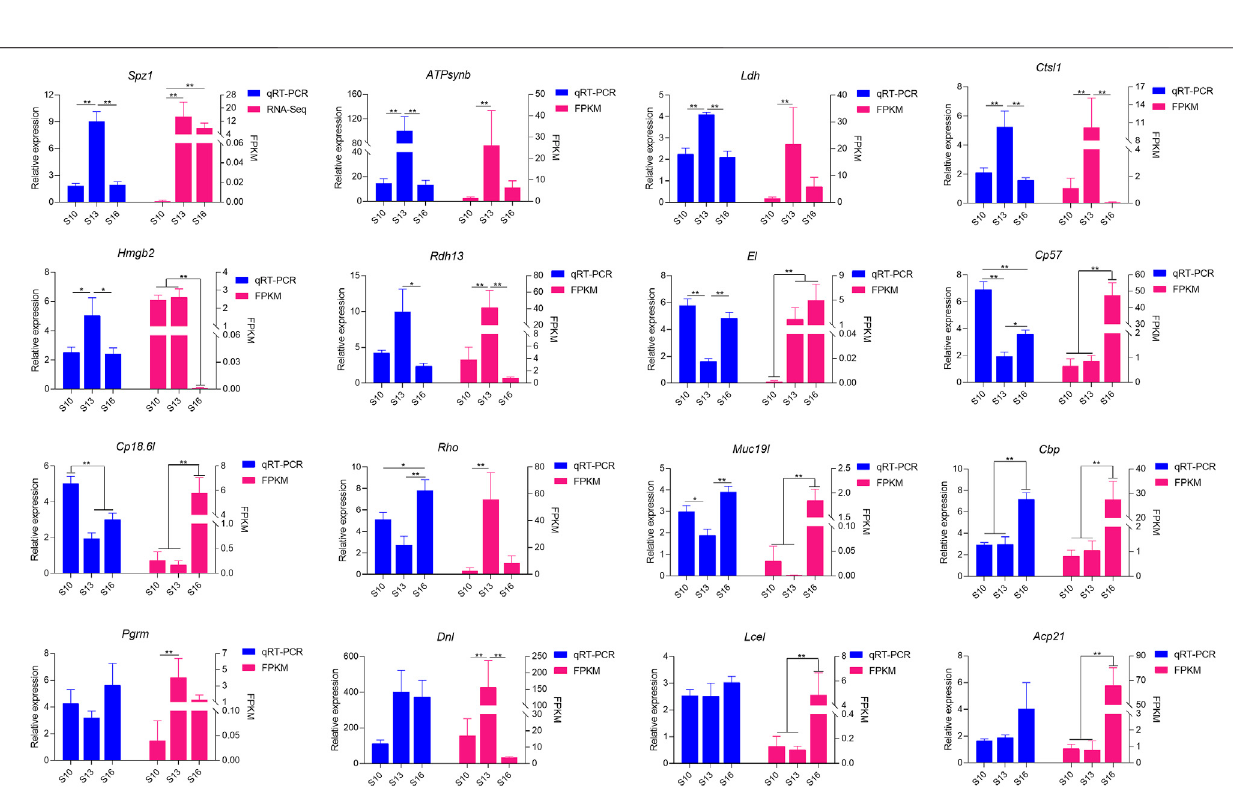
FIGURE 6 | Validation of the 16 DEG pro fi les by